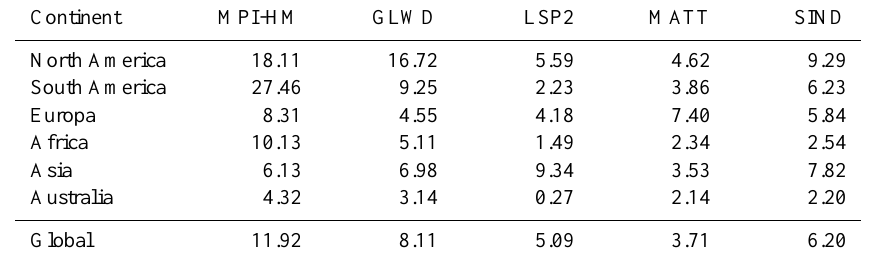
Table 1. Simulated and observed maximal wetland cover for different continents in percent of the global land surface without